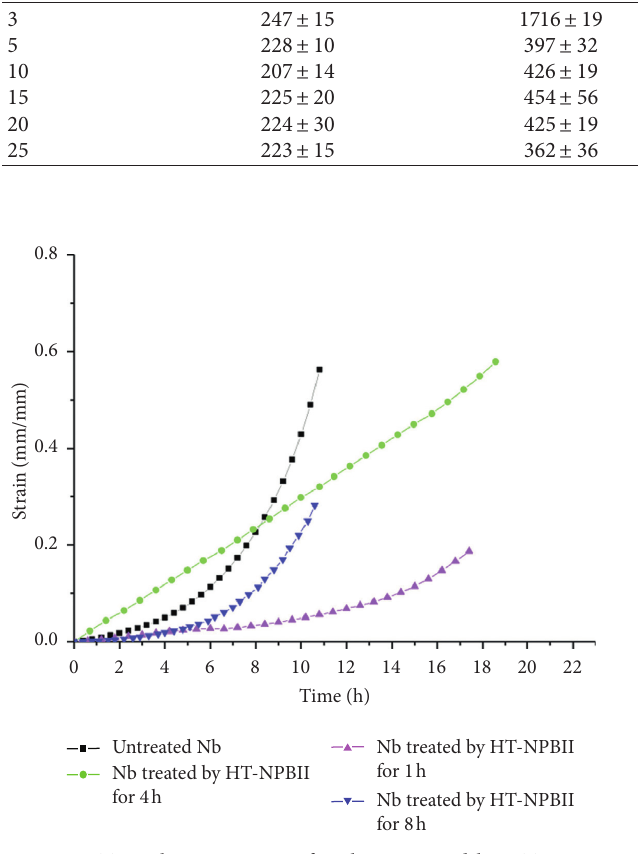
Table 1: Hardness distribution measured for treated and untreated samples in different regions of the material. Depth ( μ m)